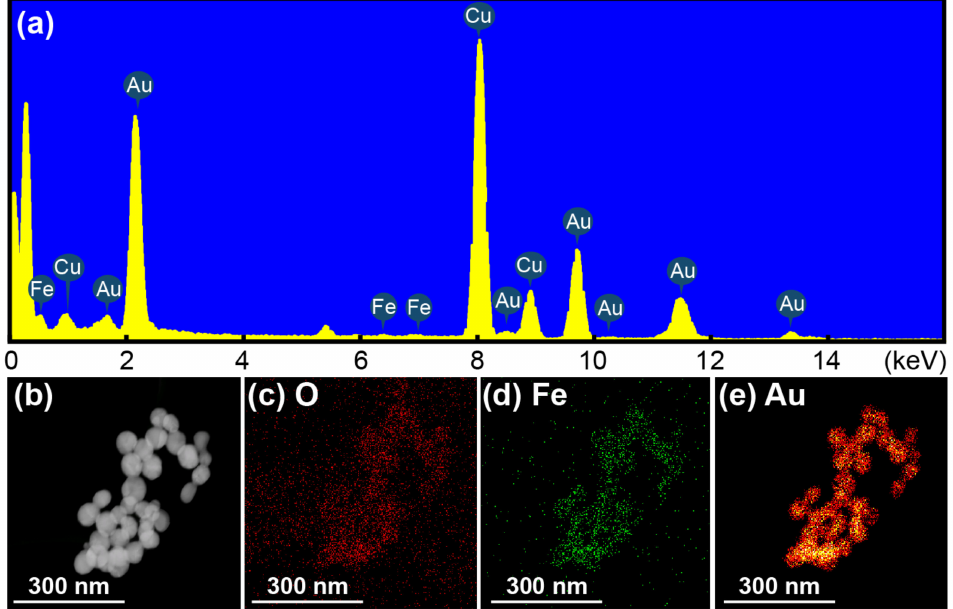
Figure 5. ( a ) EDX spectra of 3:200 GMPs, ( b ) SEM image of 3:200 GMPs, and its EDX elemental mapping of ( c ) O, ( d ) Fe, and ( e )